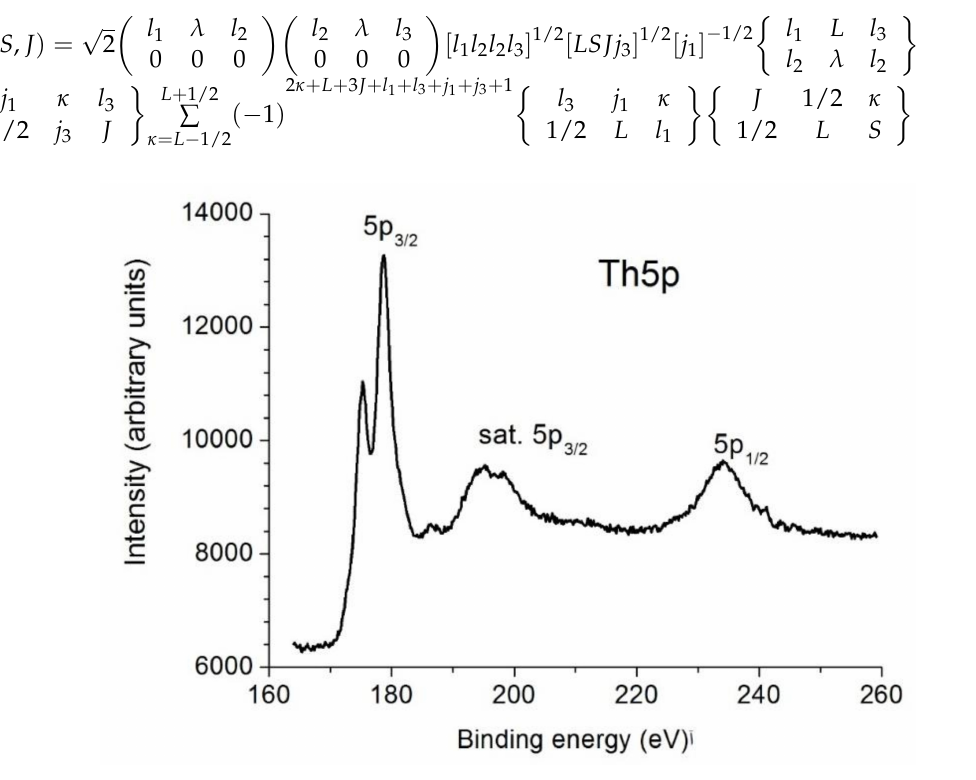
Figure 8. Experimental Th5 p photoelectron spectrum of ThO 2 [44].